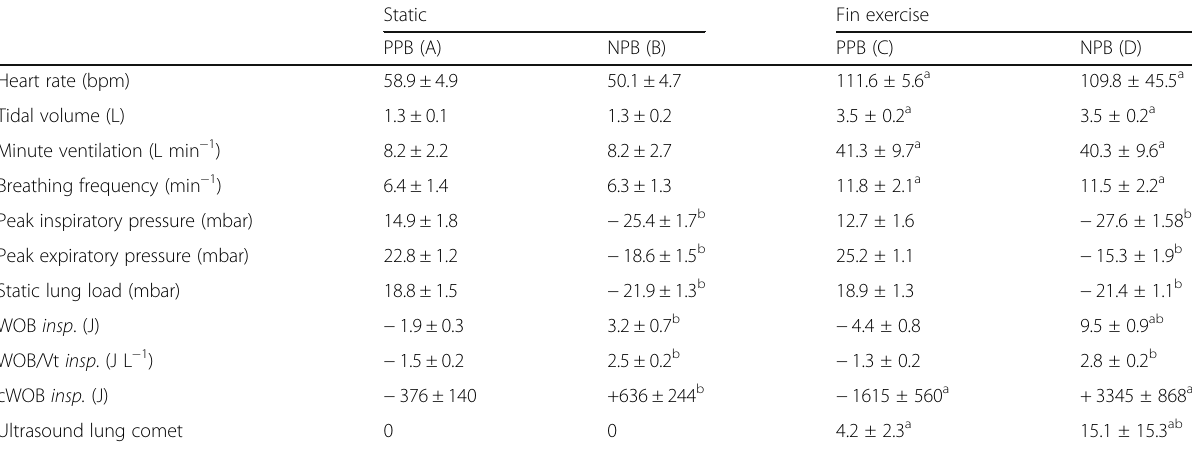
Table 1 In-water heart rate and ventilatory variables at the end of the four dive sessions